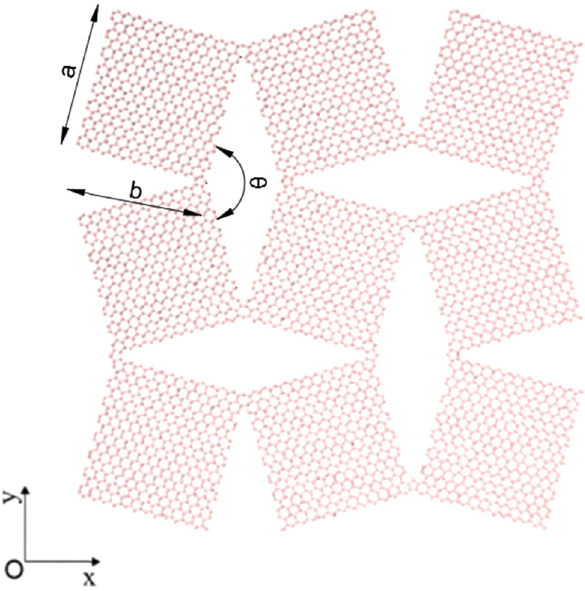
Figure 2: PRGNs: a = b = 3 nm; θ =